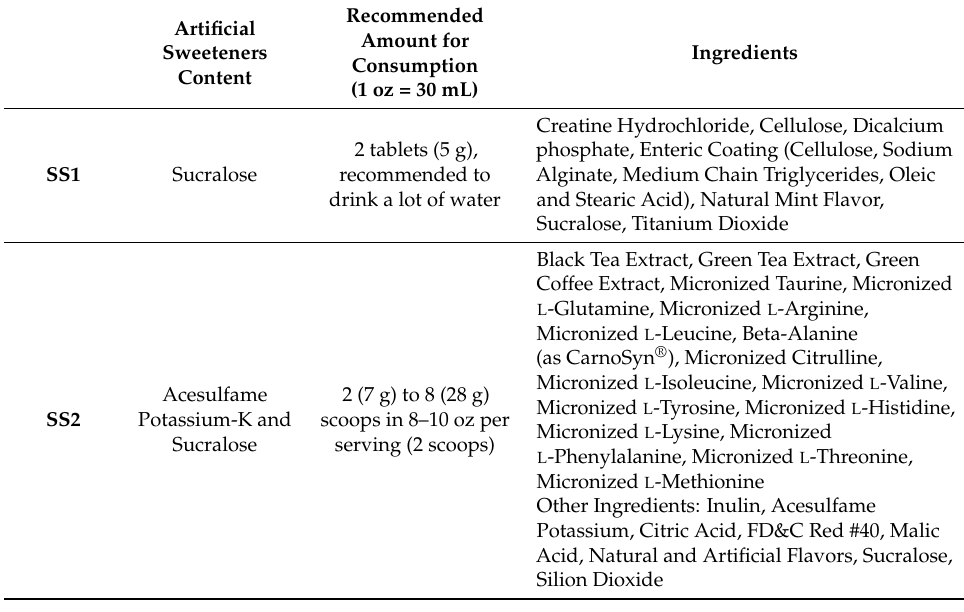
Table 3. Sport supplement